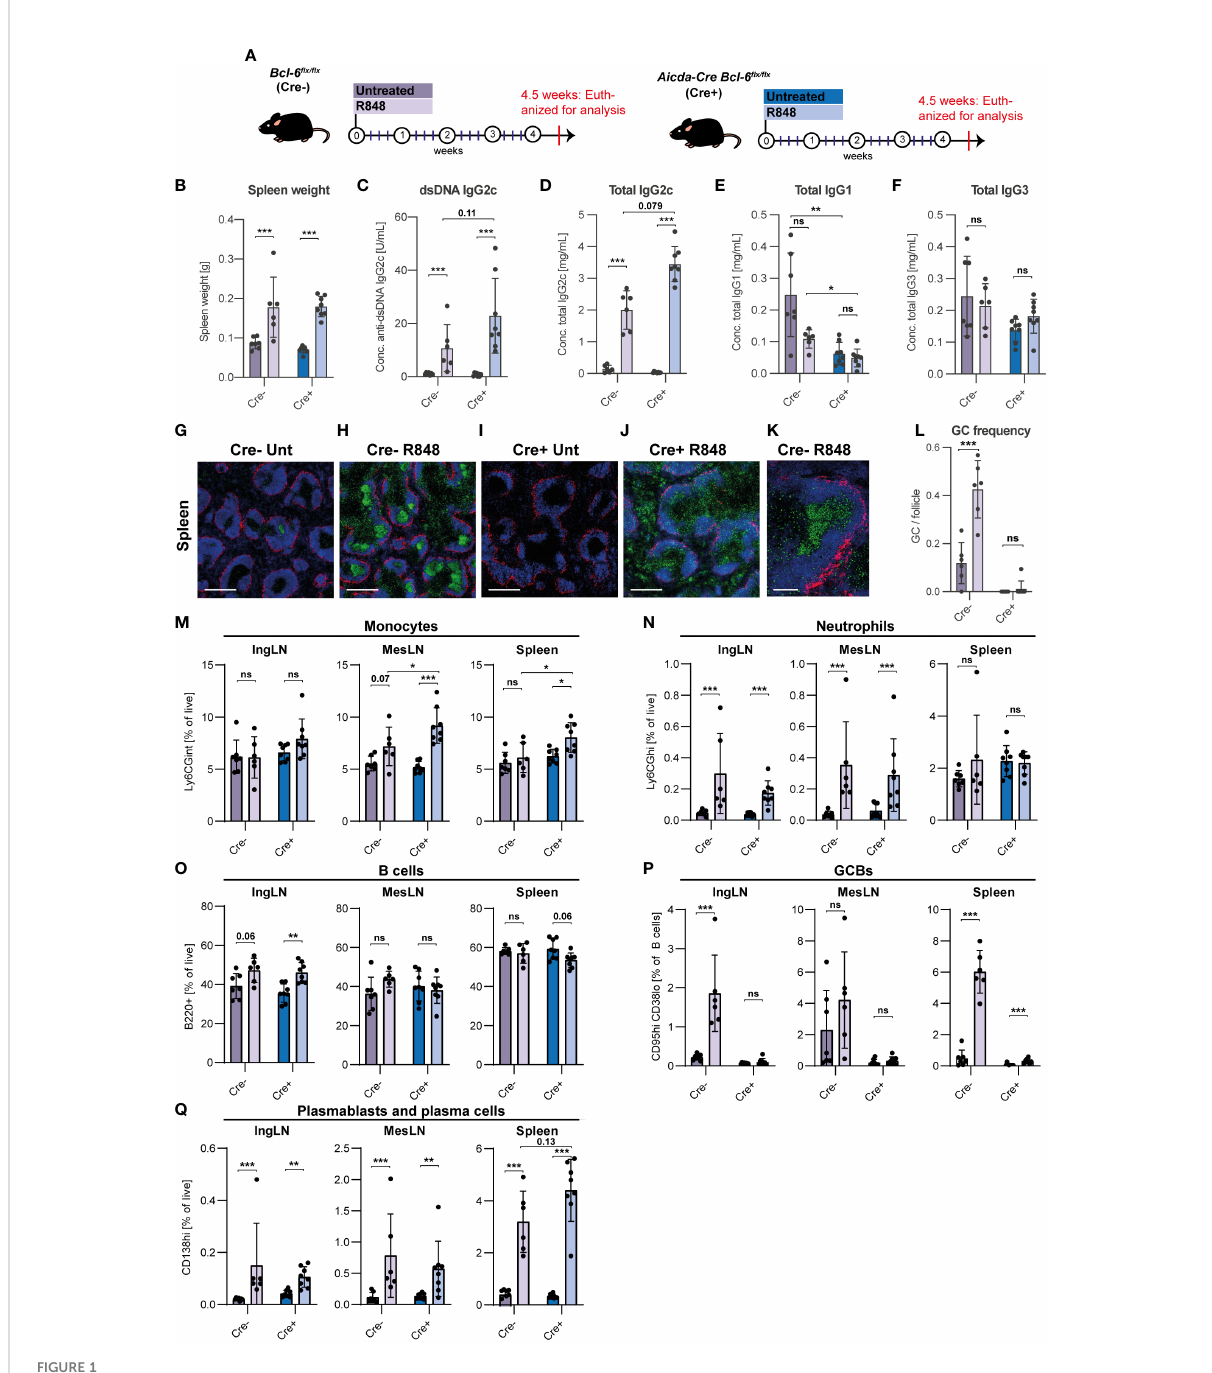
FIGURE 1 GC block fails to prevent development of autoantibodies and PB/PC expansion in lupus mice. (A) Overview of experimental setup. Bcl-6 fl x/ fl x (Cre-, purple) and Aicda-Cre Bcl-6 fl x/ fl x (Cre+, blue) mice were left untreated (dark color, n=7 and n=8, respectively) or treated with R848 (light color, n=6 and n=8, respectively). (B) Spleen weights. (C) Anti-dsDNA IgG2c. (D) Total IgG2c. (E) Total IgG1. (F) Total IgG3. (G) Representative confocal micrograph of spleen from Cre- untreated animal, stained for CD169 (red), IgD (blue) and Ki67 (green). Scale bar is 400 µm. (H) As G, but for Cre- treated animal. (I) As G, but for Cre+ untreated animal. (J) As G, but for Cre+ treated animal. (K) High-resolution image of GC from Cre- treated mouse. Scale bar=100 µm. (L) GC/follicle in spleen. (M) Flow cytometry analyses of monocyte frequencies (Ly6CG int ) in IngLN, MesLN, and spleen. (N) As M, but neutrophil frequencies (Ly6CG hi ). (O) As M, but B cell frequencies (B220 + CD4 - CD8 - ). (P) As M, but GCB frequencies (CD95 hi CD38 lo ). (Q) As M, but PB and PC frequencies (CD138 hi ). Data pooled from two independent experiments. Bar graphs show mean ± SD. ns = p ≥ 0.05, *p < 0.05, **p < 0.01, ***p < 0.001, based on two-way ANOVA with Holm-Sidak ’ s